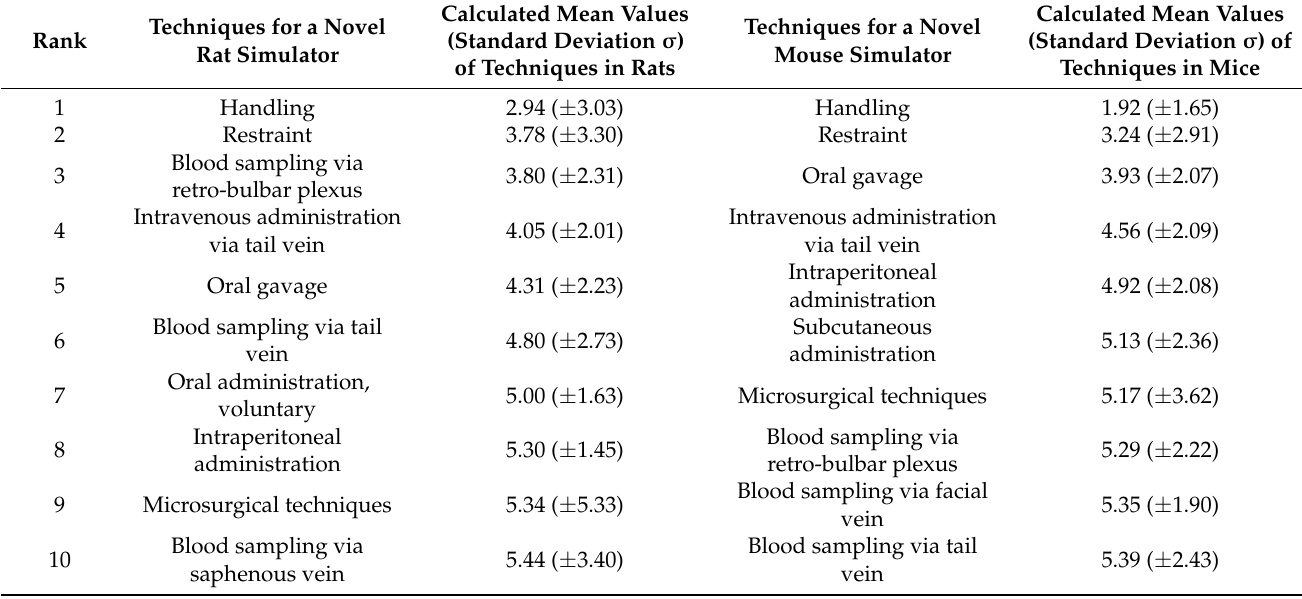
Table 3. Descriptive analysis of methodical requirements for a novel simulator. Distribution of replies ( n = 35) concerning the top 10 techniques most desired to be practiced on a novel rat or mouse simulator as ranking question (highest priority at top). A maximum of 10 out of 20 suggested answers could be ranked. Data are shown as calculated mean values for each technique and